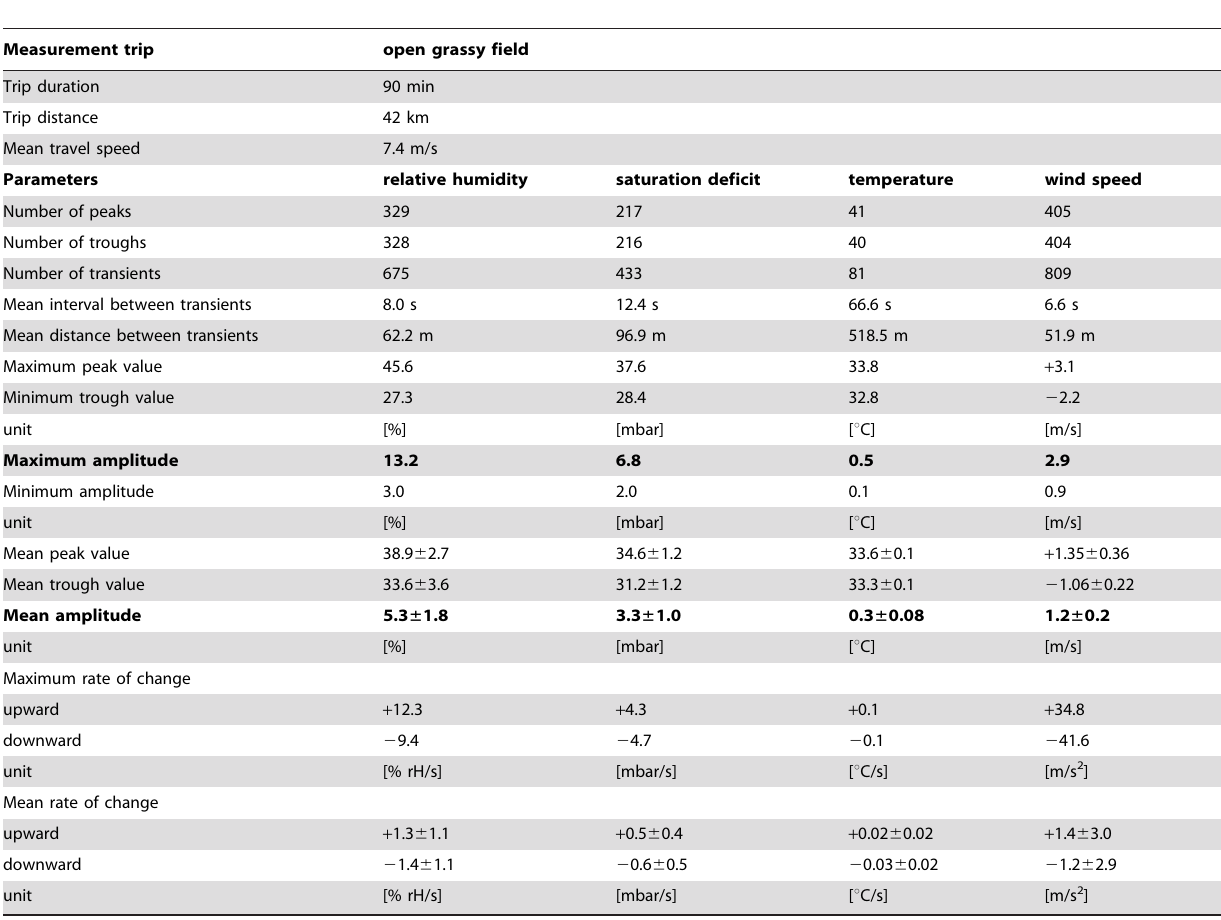
Table 2. Fluctuation statistics of humidity, temperature and wind speed values for a typical measurement trip through an open grassy